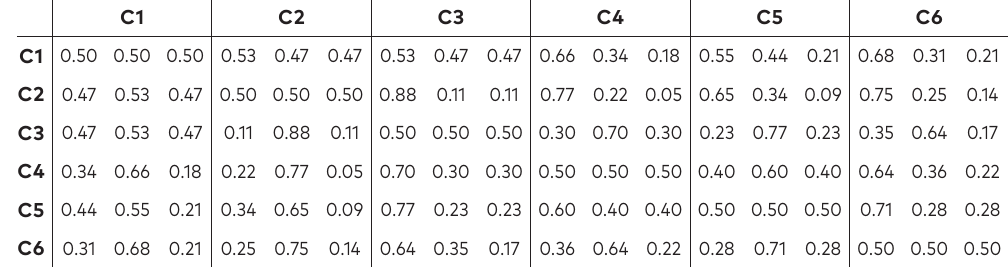
Table 7. The ′ R matrix